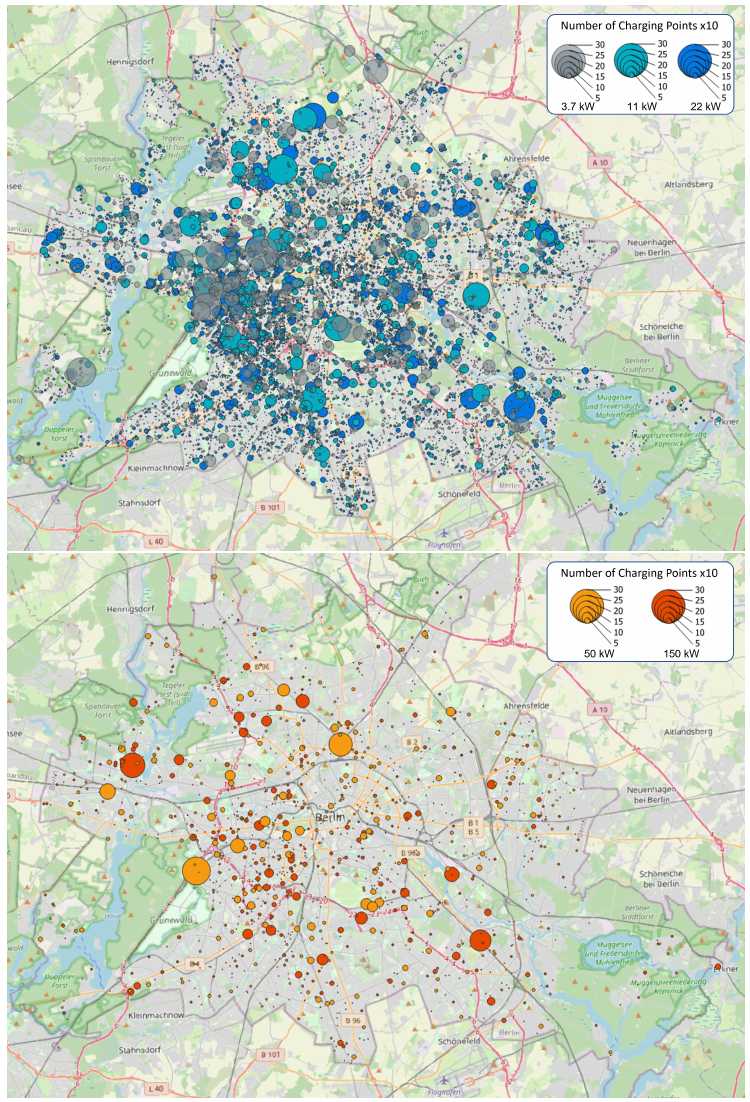
Figure 10. Spatial distribution of public charging infrastructure in mid-front